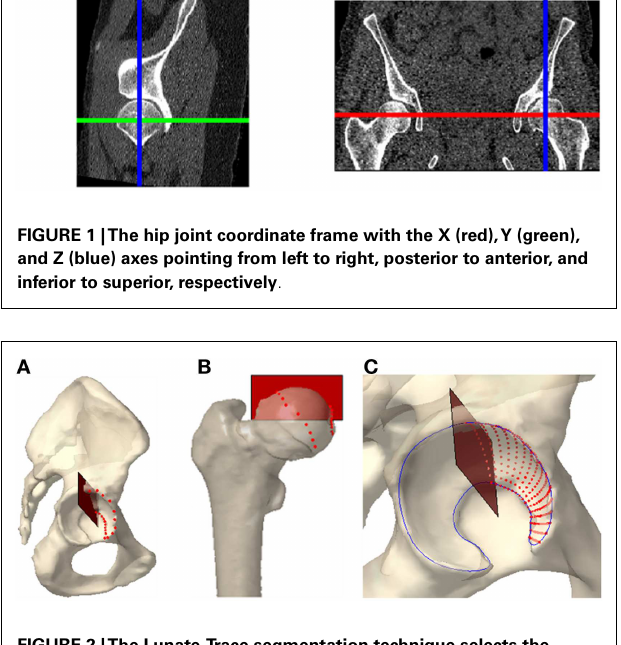
FIGURE 2 |The Lunate-Trace segmentation technique selects the lateral and medial edges of the contact surface on (A) the acetabulum and (B) the femoral head. (C) Radial and polar interpolation between the edge points yield arc cross sections of the contact